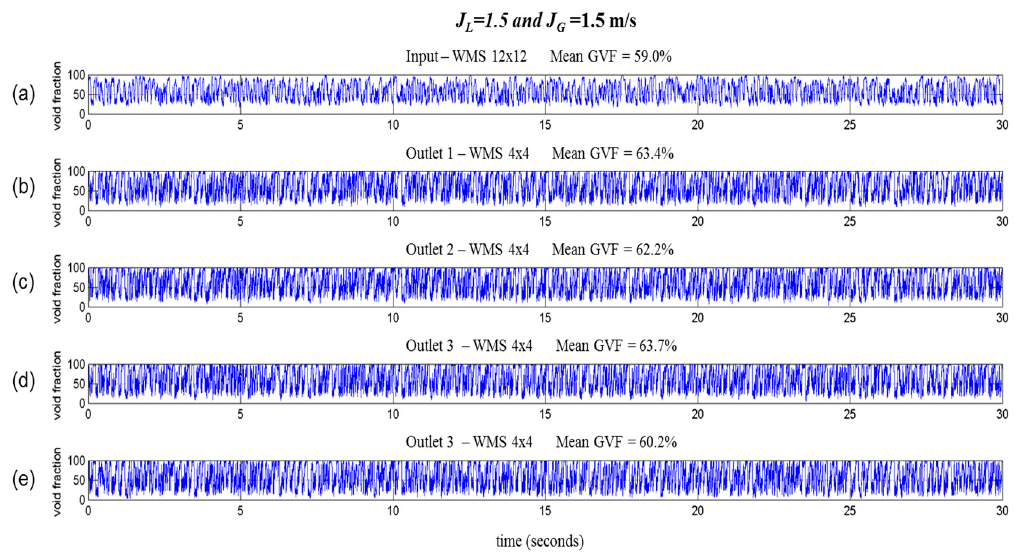
Figure 10. Axial and transversal view of the void fraction, using the wire-mesh sensor in two-phase flow with J L = 1.0 m/s and J G = 1.0 m/s. ( a ) Input and ( b – e ) outlets 1–4.